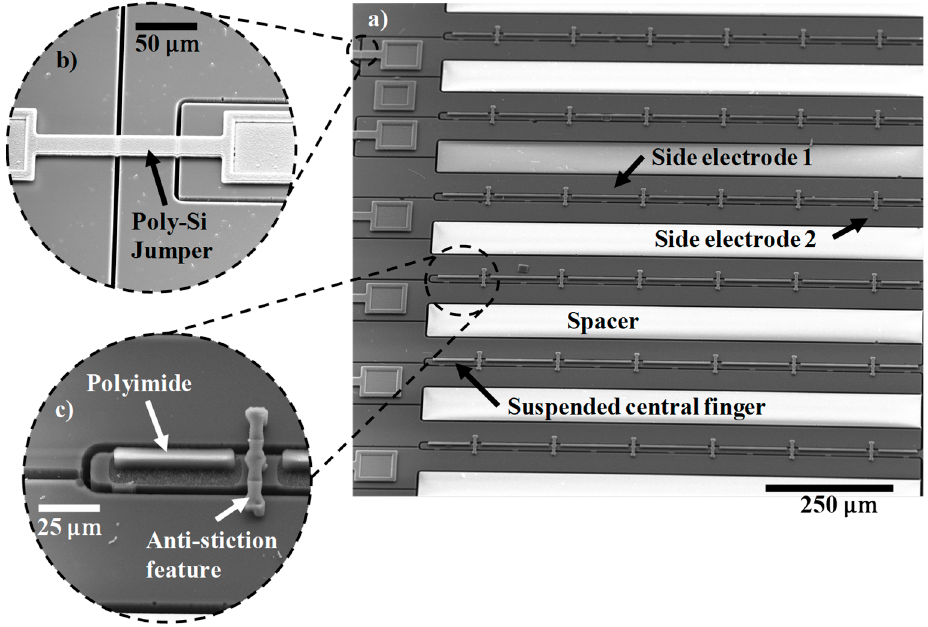
Figure 5. ( a ) LACM sensor array; ( b ) zoomed-in image of a poly-Si jumper over etched trenches acting as the second level of electrical connections; ( c ) magnified view of a suspended central finger with asymmetrically patterned polyimide and anti-stiction micro-staple holder.